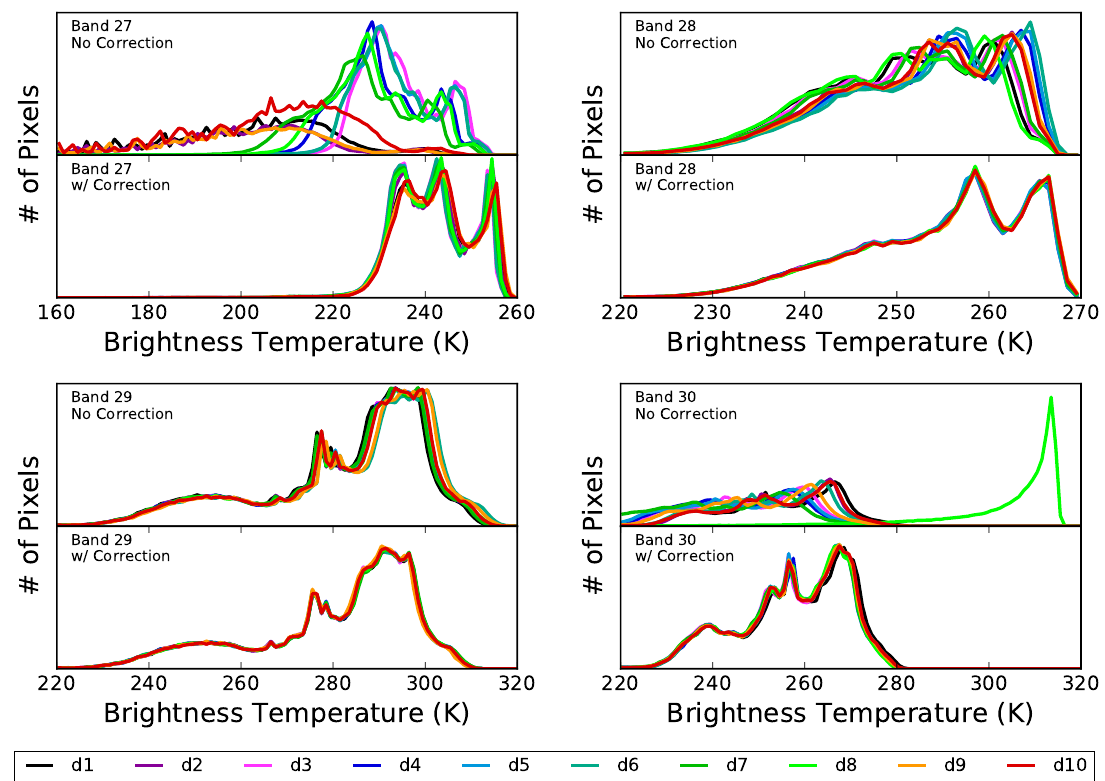
Figure 10. Histograms of the brightness temperature retrieval for the entire granule that contains the image in Figure 9 (2016143.1655) before and after correction for each LWIR PV band.